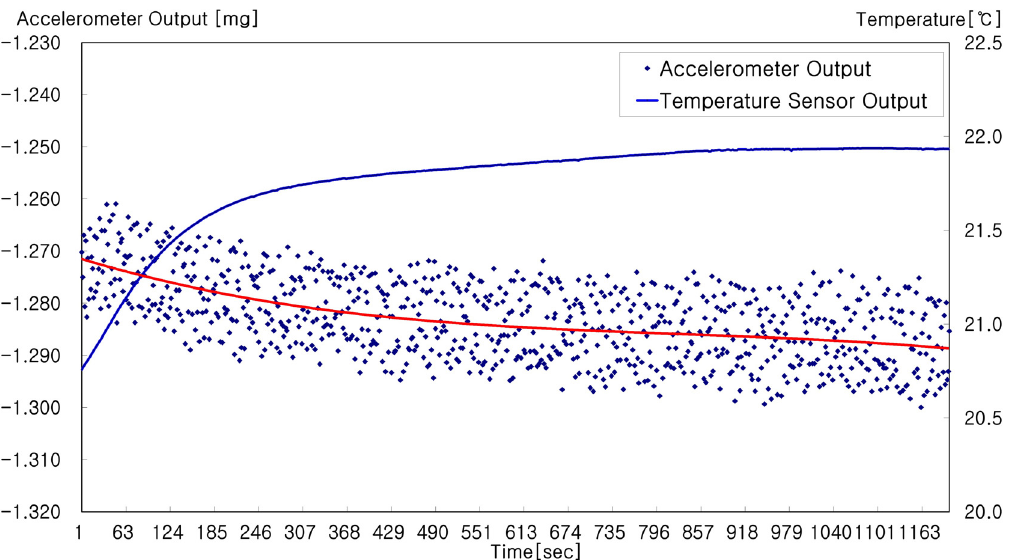
Figure 2. Accelerometer output in the temperature stabilizing state. Right after an accelerometer is powered on, the temperature inside increases rapidly. That temperature change causes an accelerometer temperature stabilizing error.